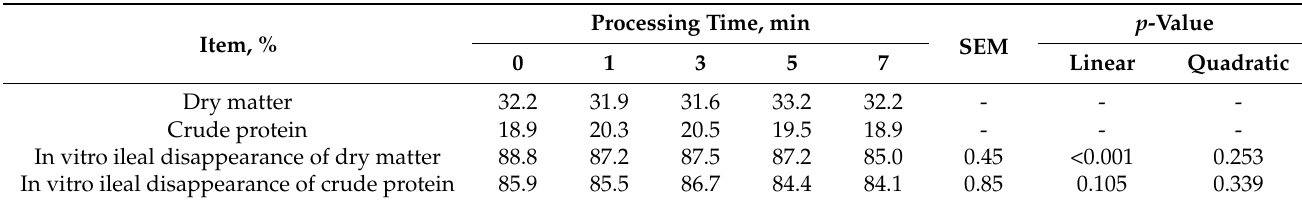
Table 4. Dry matter and crude protein concentrations in high-pressure processed chicken meat (as-is basis) and effects of processing time on in vitro ileal disappearance of dry matter and crude protein of high-pressure processed chicken meat (Exp. 4) 1,2 .